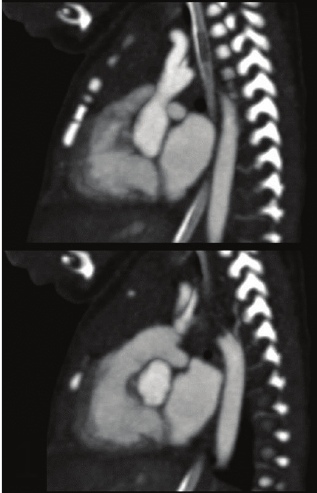
Figure 1: Computed tomography showing the aortic arch which appears to be interrupted with a radiodense lesion distal to the left subclavian artery.